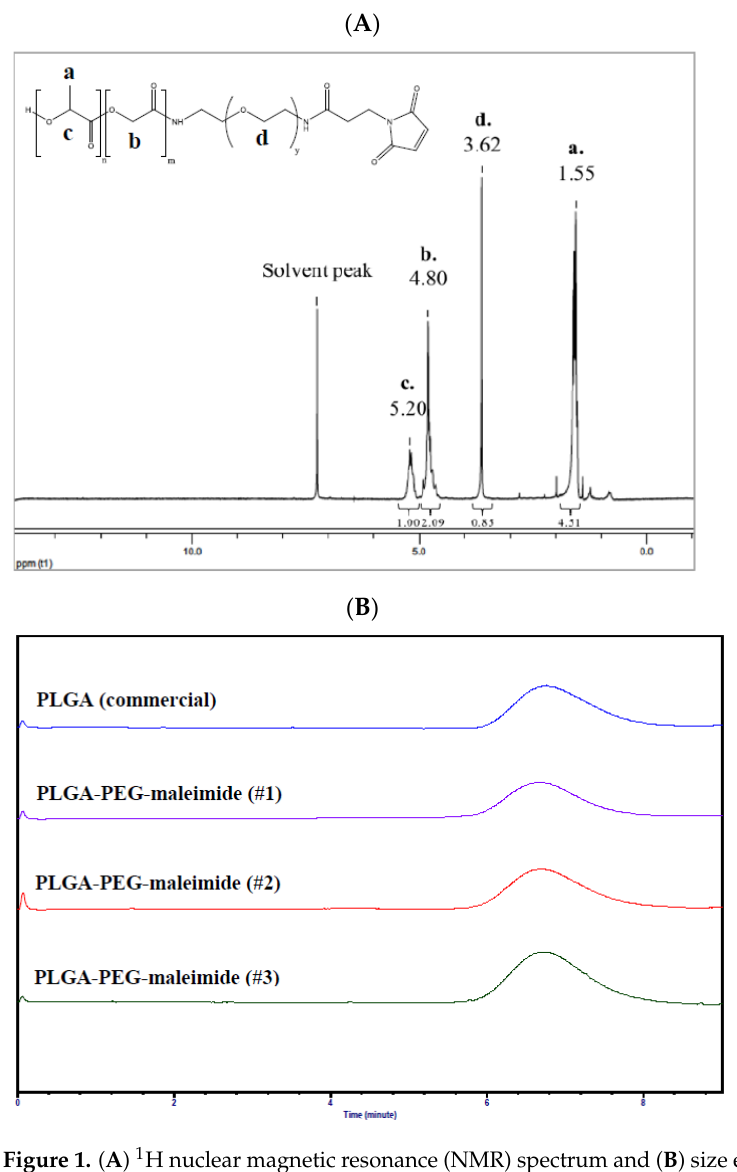
Figure 1. ( A ) 1 H nuclear magnetic resonance (NMR) spectrum and ( B ) size exclusion chromatograms of poly( D , L -lactide-co-glycolide)-poly(ethylene glycol)-maleimide (PLGA-PEG-mal, n = 3).